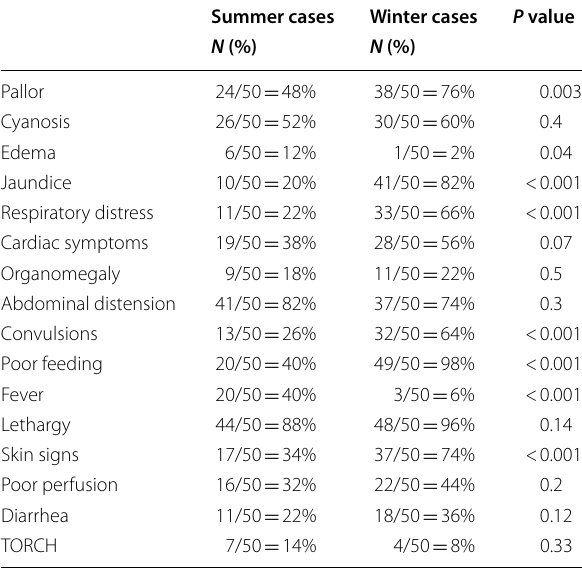
Table 4 Comparison between symptoms and